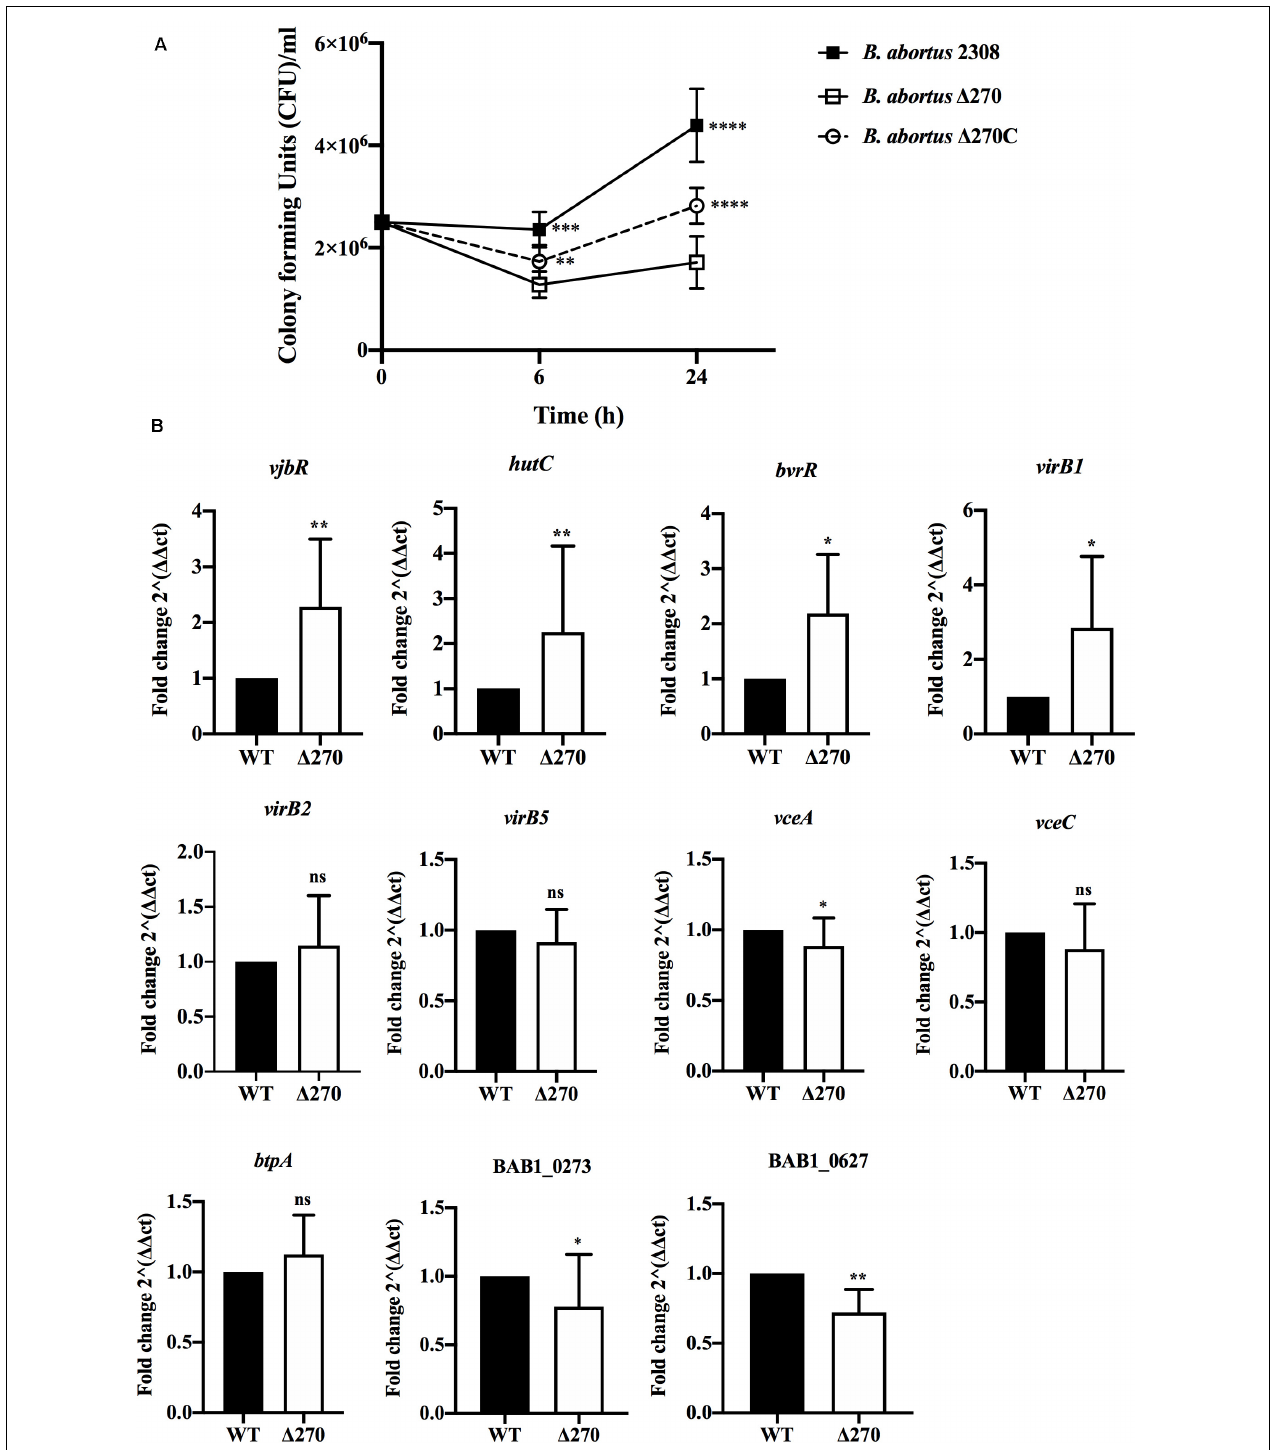
FIGURE 4 | Intracellular survival and gene expression of B. abortus strains in macrophages. (A) Intracellular bacteria were obtained from macrophages infected at 1:10 MOI with B. abortus 2308, B. abortus (cid:49) 270, or B. abortus (cid:49) 270C at 6 and 24 h pi. Intracellular survival was recorded as mean ± standard deviation of bacterial counts as CFU/mL. (B) The relative expression of vjbR , hutC , bvrR , virB1 , virb2 , virB5 , vceA, vceC, btpA, and the ORFs BAB1_0273 (GI-3) and BAB1_0627 induced in B. abortus 2308 (wt) and B. abortus (cid:49) 270 during macrophage infection was calculated by the 2 − (cid:49)(cid:49) CT method using qPCR assays at 24 h pi. The housekeeping genes gyrA and 16s were used as reference genes. Results were expressed as the mean ± standard deviation. Values of P < 0.05 were considered statistically significant, where ns denotes non-significant differences, *, **, ***, and **** denote values of P < 0.05, P < 0.01, P < 0.001, and P < 0.0001, respectively. All assays were performed in